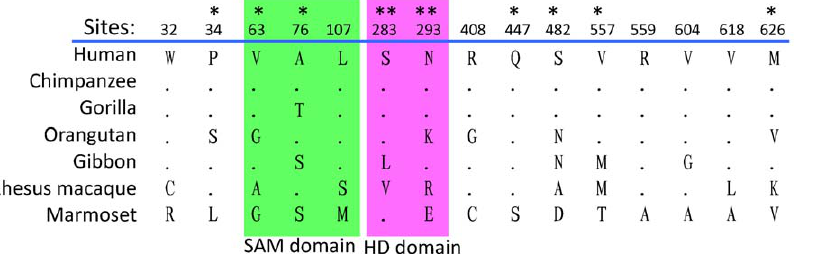
Figure 2. Positively selected residues in primate SAMHD1 proteins. The black small dots indicate identical residues compared to the human SAMHD1 sequence. Positive selected sites were identified with posterior probabilities . 0.90. One and two asterisks indicate posterior probabilities $ 0.95 and 0.99, respectively. The green and pink shadows indicate the SAM and HD domains, respectively.